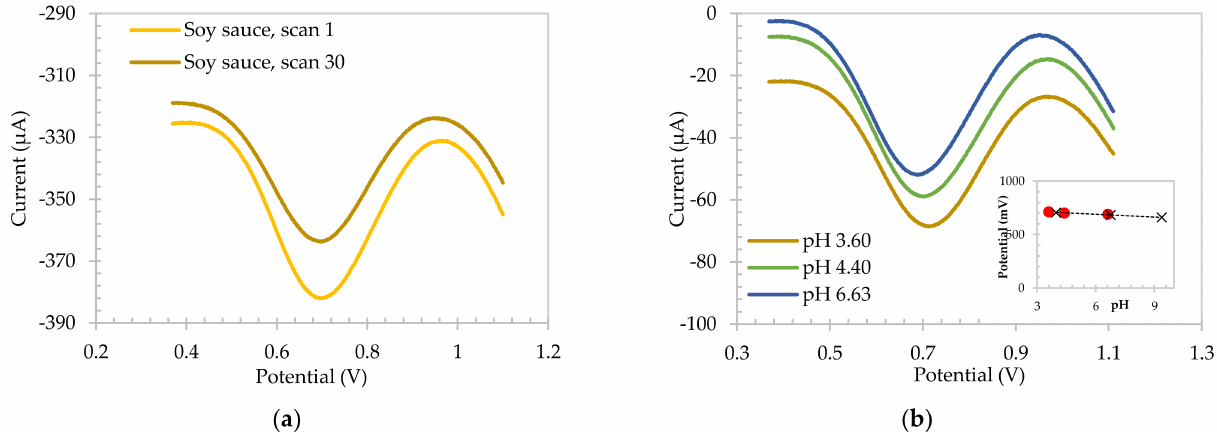
Figure 2. Square wave voltammograms for ( a ) scan 1 and scan 30 of SA electrode electropolymerized in soy sauce. ( b ) SA electrodes in soy sauce over different pH values, and calibration plot obtained in soy sauce and IUPAC standard buffers